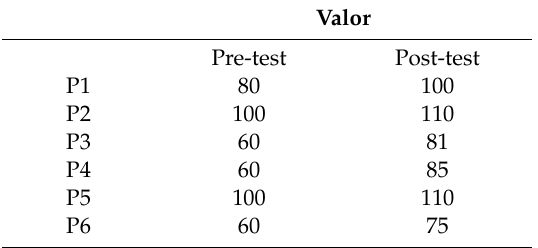
Table 4. Grouped pre-test / post-test results of the Global Emotional Intelligence Test. Valor Pre-test Post-test